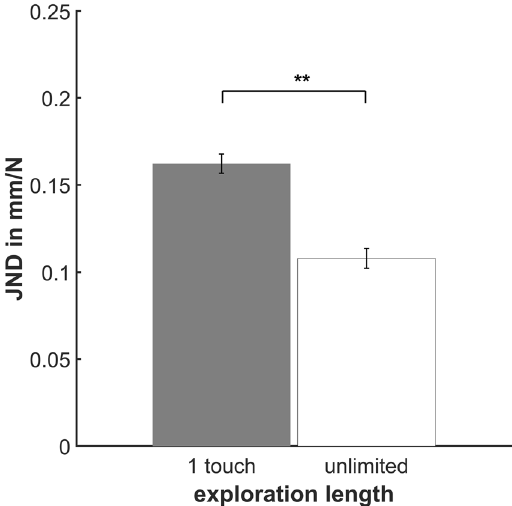
Figure 3. Average JNDs. Experiment 4: Average discrimination thresholds for softness of silicon stimuli explored with a pen given different length of the exploration (one touch or unlimited). JNDs were averaged over the object surface conditions. Error bars represent the within-subject standard error 60 . ** p <